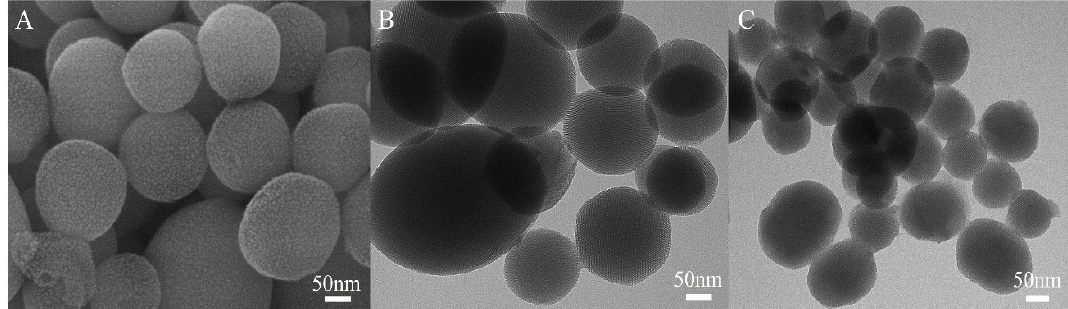
Figure 4. SEM image of MSNs ( A ) and TEM images of MSNs ( B ); MSN-SS-Fc@ β -CD-PNIPAM complex nanoparticles (C).